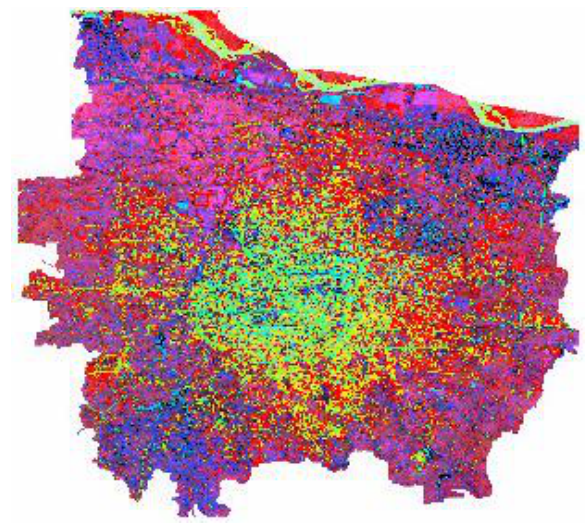
Fig. 3. Color transformation